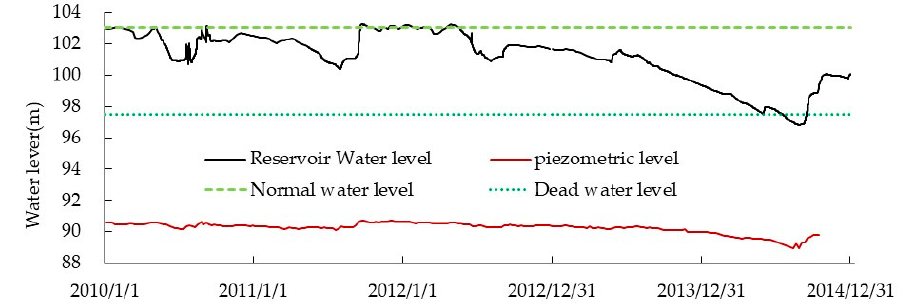
Figure 3. Time series of measured reservoir water level and piezometer water level.